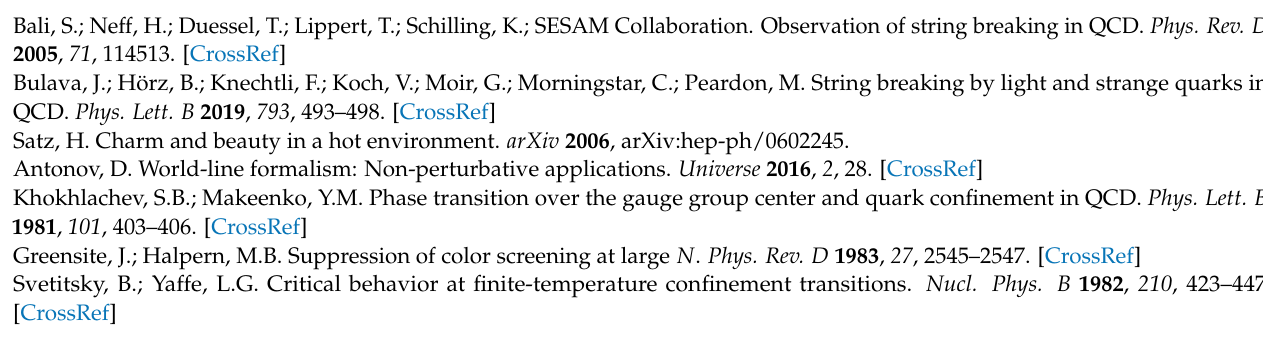
(cid:0) (cid:1) 0.195 1 − T T c